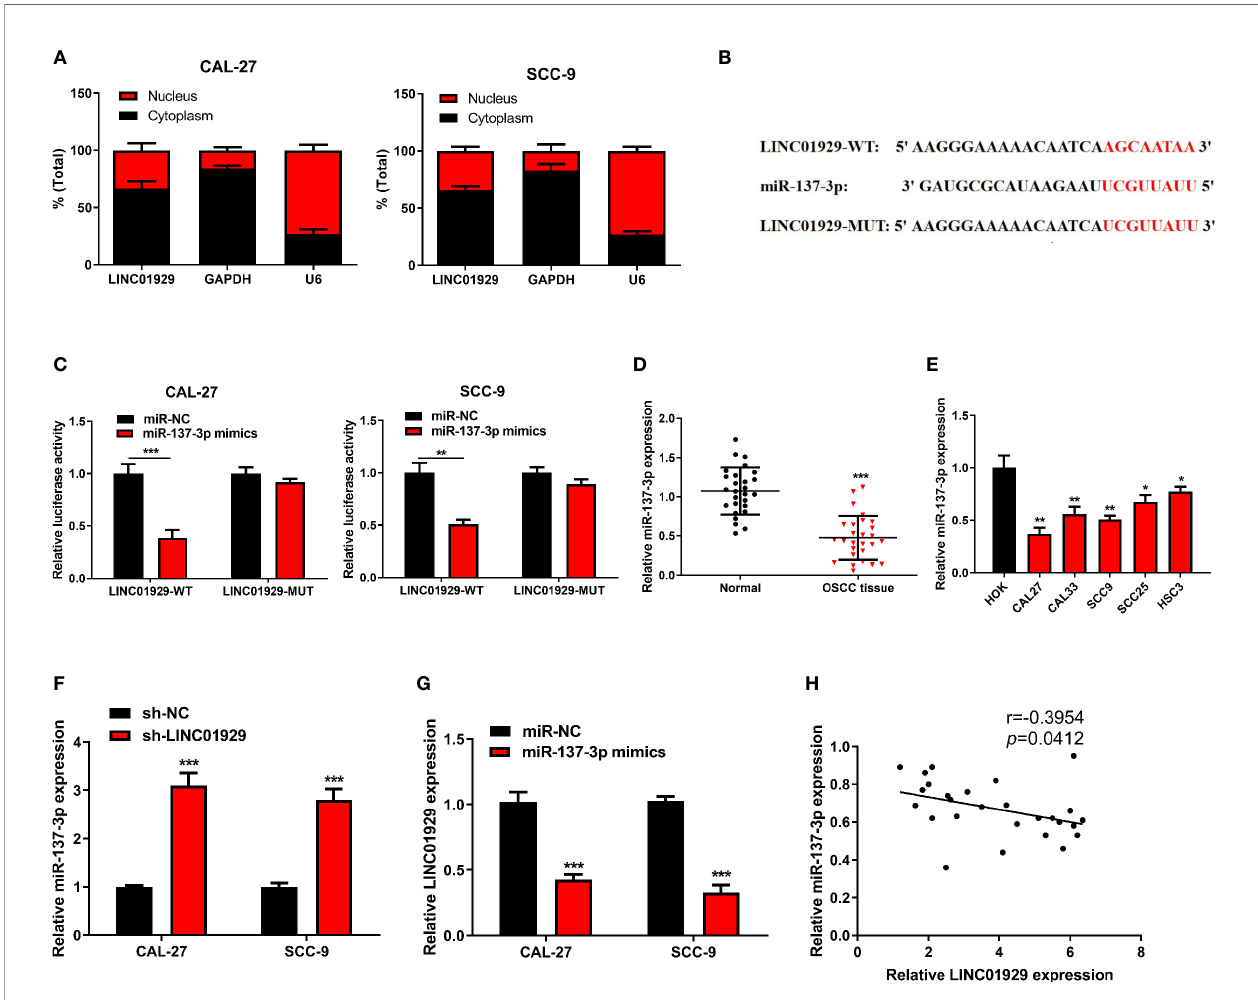
FIGURE 3 | LINC01929 sponged miR-137-3p in OSCC cells. (A) Identi fi cation of LINC01929 expression by nuclear and cytoplasmic fractionation to analyze its subcellular location. (B) The binding site between LINC01929-MUT and miR-137-3p was predicted with bioinformatics analysis. (C) The luciferase gene reporter assay was applied to test the binding relationship between LINC01929 and miR-137-3p mimics. (D, E) The miR-137-3p expression was detected by qRT-PCR in OSCC tissues and OSCC cells. (F) The miR-137-3p expression was identi fi ed in LINC01929 knockdown OSCC cells. (G) The LINC01929 expression was tested after transfecting with miR-137-3p mimics into OSCC cells. (H) Spearman ’ s correlation analysis was used to analyze the relevance between LINC01929 and miR- 137-3p. *p < 0.05, **p < 0.01, ***p <